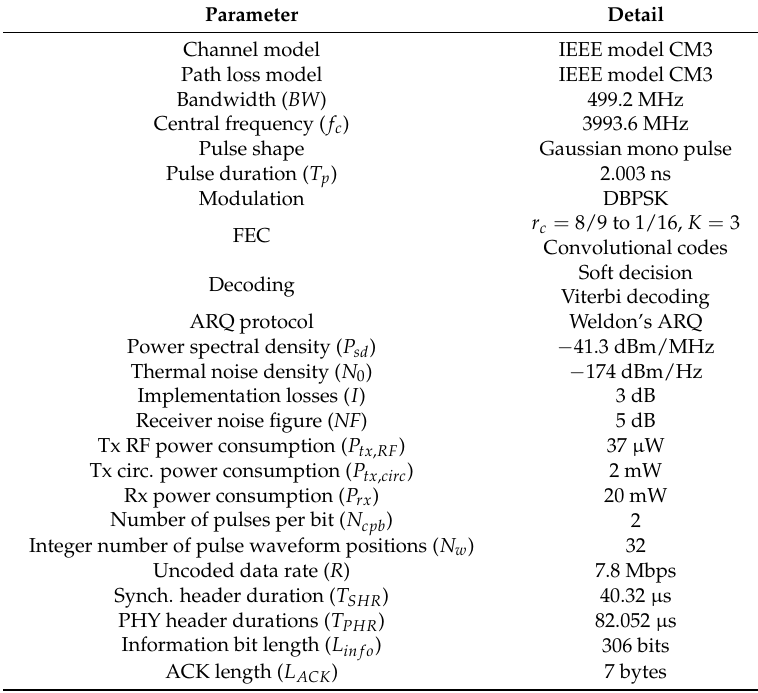
Table 3. Main simulation parameters.